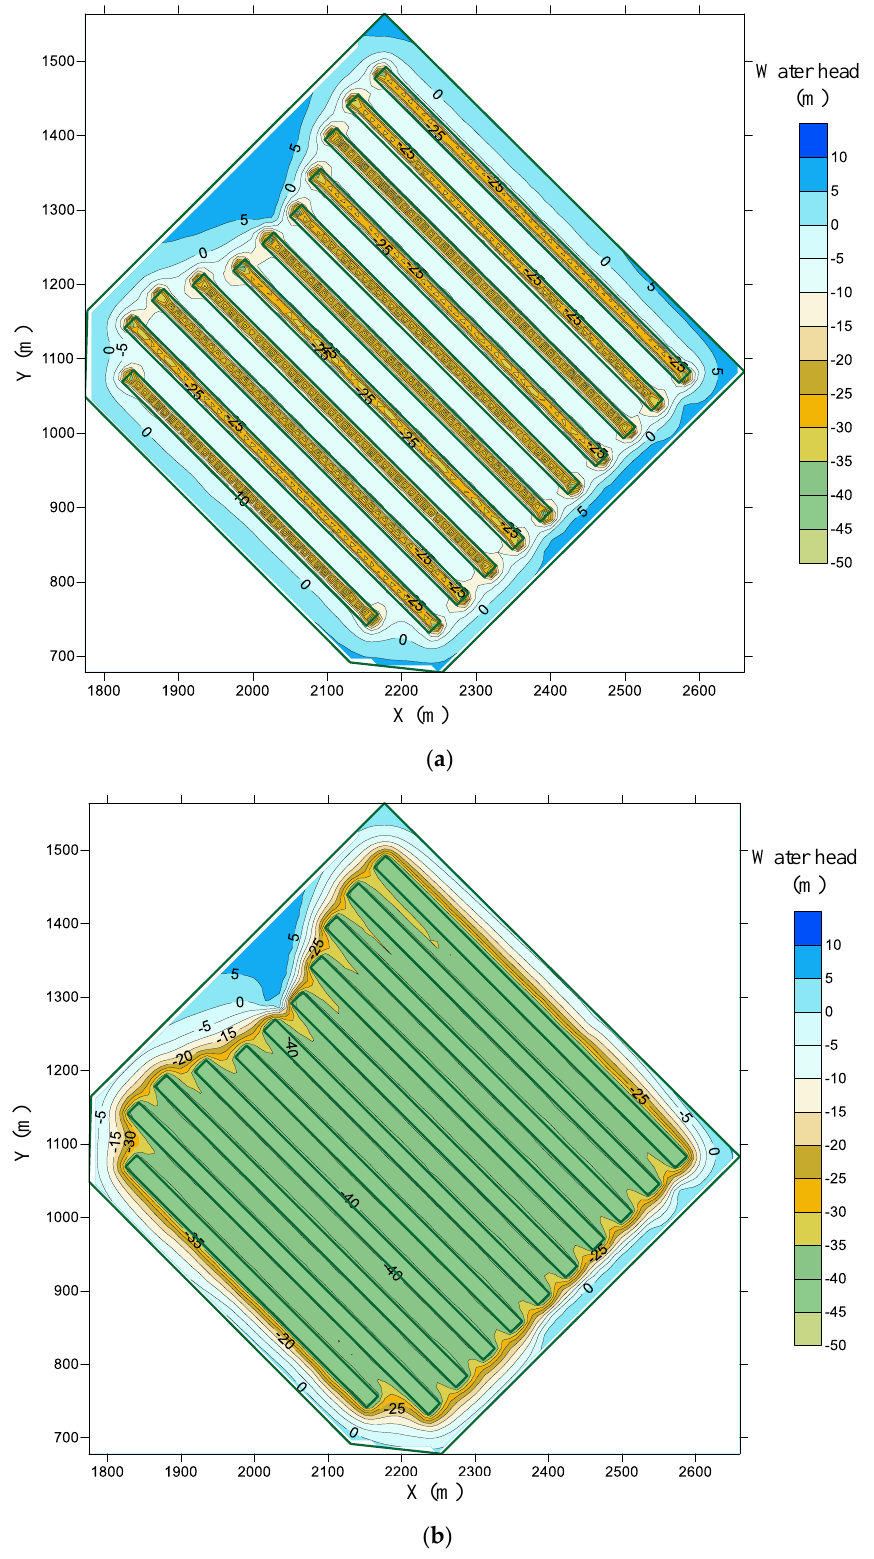
Figure 16. Water head contours when setting horizontal water curtain system: ( a ) at the cavern top ( − 62 m elevation); ( b ) at the cavern bottom ( − 92 m elevation).